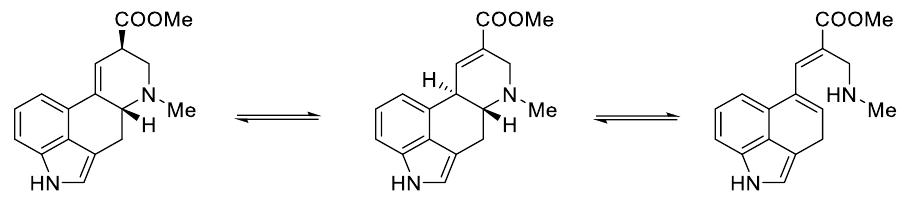
Figure 8. Equilibrium between the forms of lysergic acid, explaining the racemization mechanism.